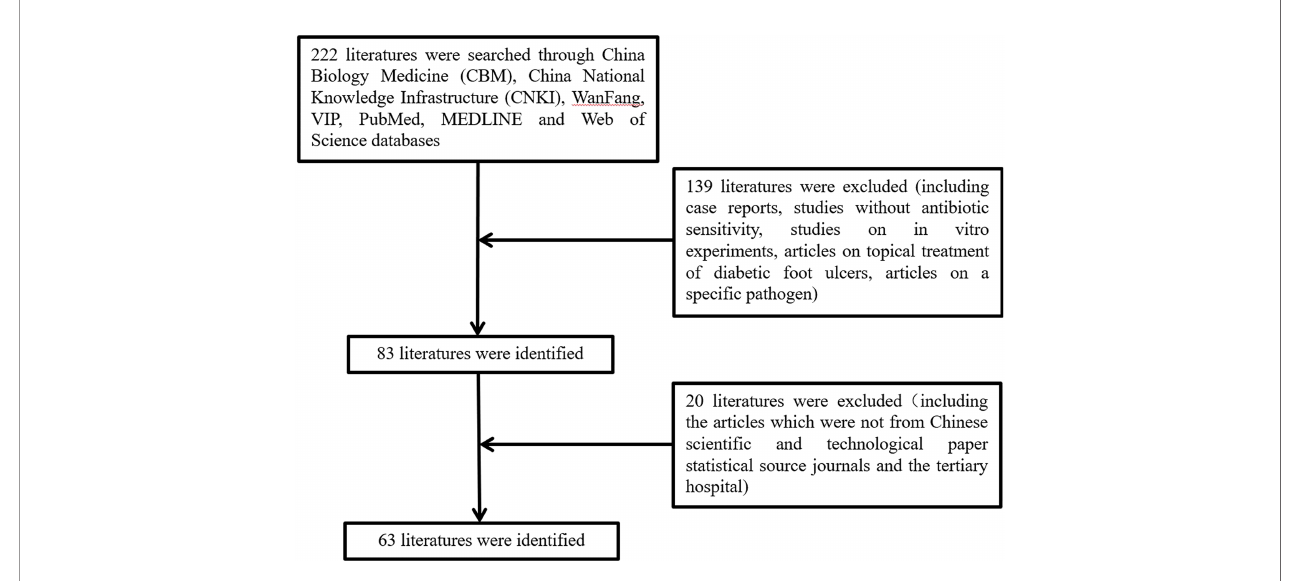
FIGURE 1 | Flow chart of literature